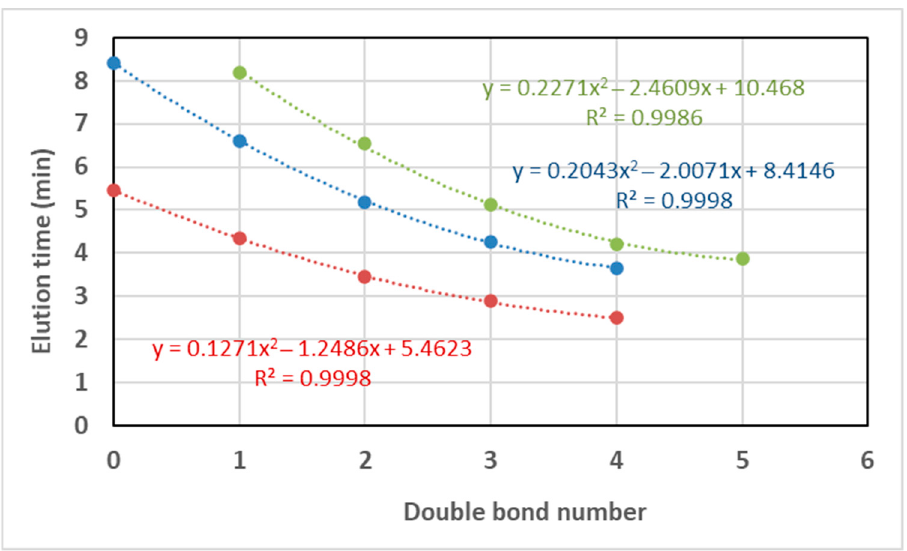
Figure 10. Correlations of elution time (min) against the double bond number for TAGs with 48 (red), 52 (blue), and 54 (green) carbons for 9.13 mM [NH 4 OH].